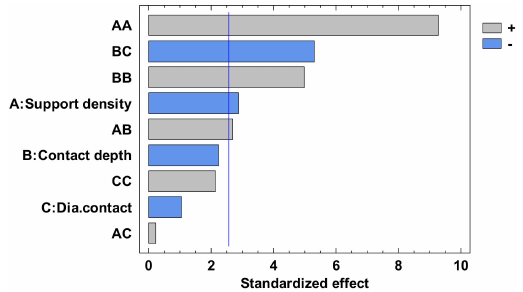
Figure 25. Standardized Pareto Chart for